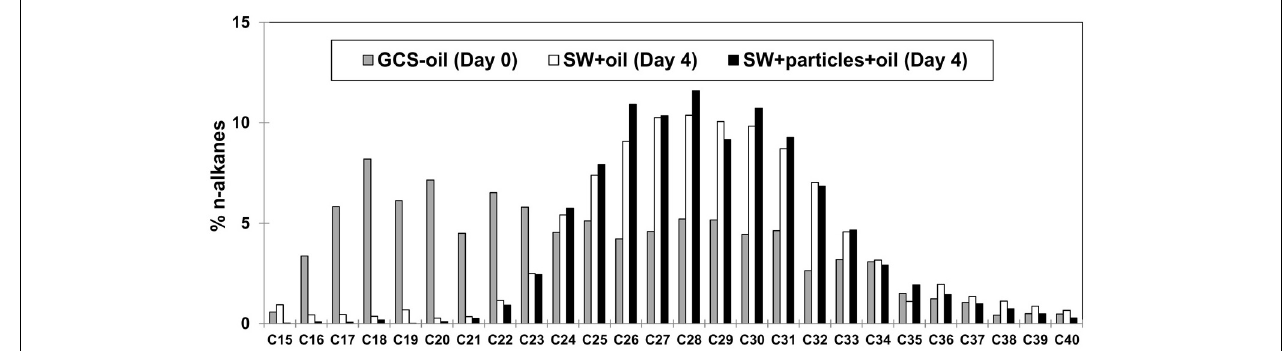
FIGURE 2 | Chemical characterization of GCS-oil. Relative distribution of n-alkanes before (Day 0) and after the roller tank incubations (Day 4). Note that all three samples were mostly depleted of < C 15 alkanes, probably due to dissolution during ascending of the oil from the seep.